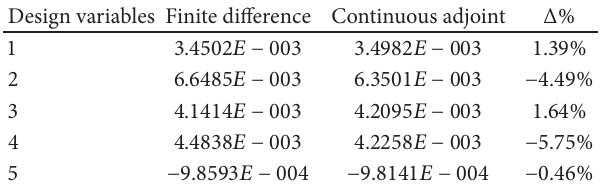
Table 3: Comparison of the sensitivities of drag coefficient. Table 4: Optimization results of ONERA